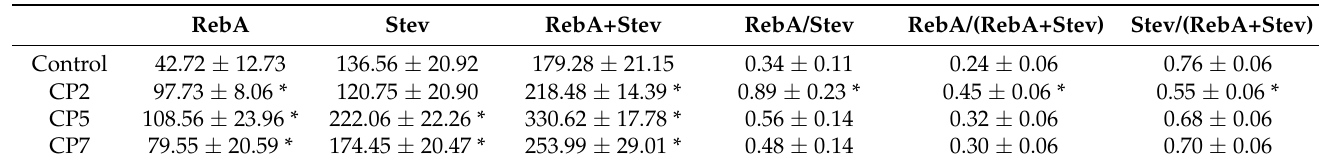
Means ± SEM are presented (n = 7); *, statistically significant difference compared to control ( p < 0.05).